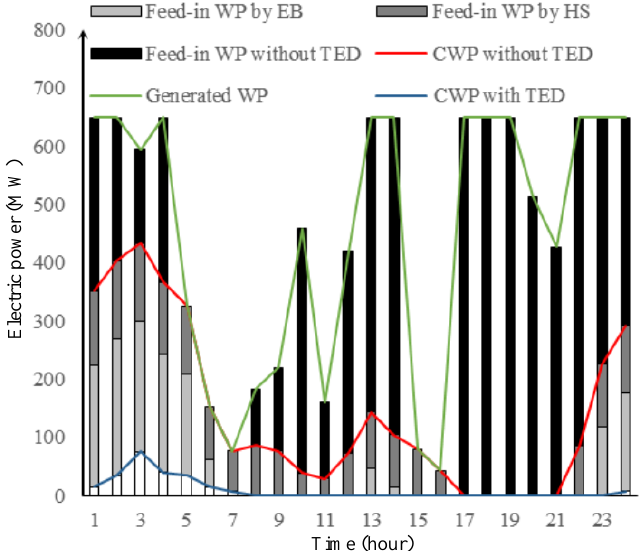
Figure 13. The condition of wind power consumption with/without TED.